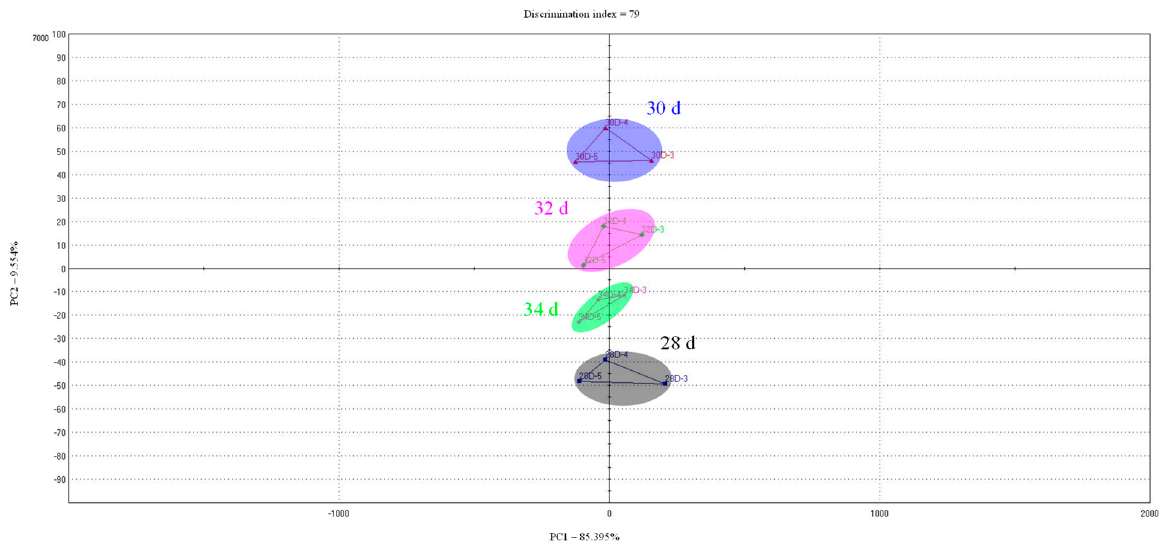
Figure 5. Principal component analysis for the taste profile of cooked cured chicken breast with various marketing ages; 28 d: cured chicken breast with 28 days of marketing age; 30 d: cured chicken breast with 30 days of marketing age; 32 d: cured chicken breast with 32 days of marketing age; 34 d: cured chicken breast with 34 days of marketing age.